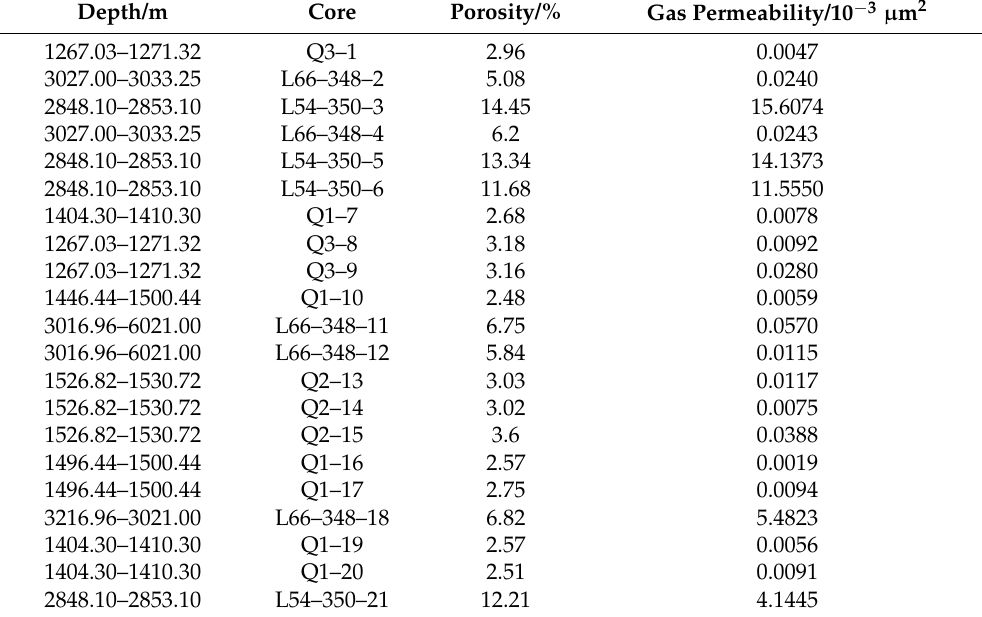
Table 1. Basic physical properties of tight sandstone